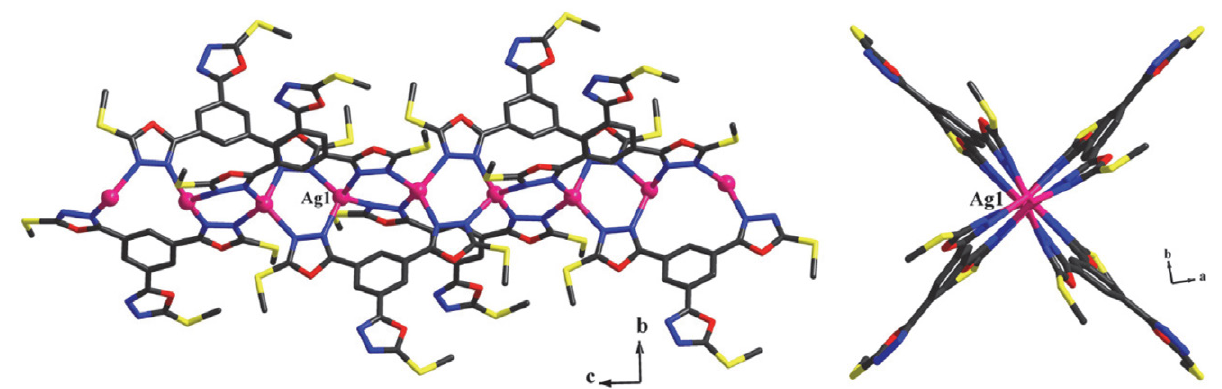
Figure 3. 1D chain structure consists of Ag1 in 1 .